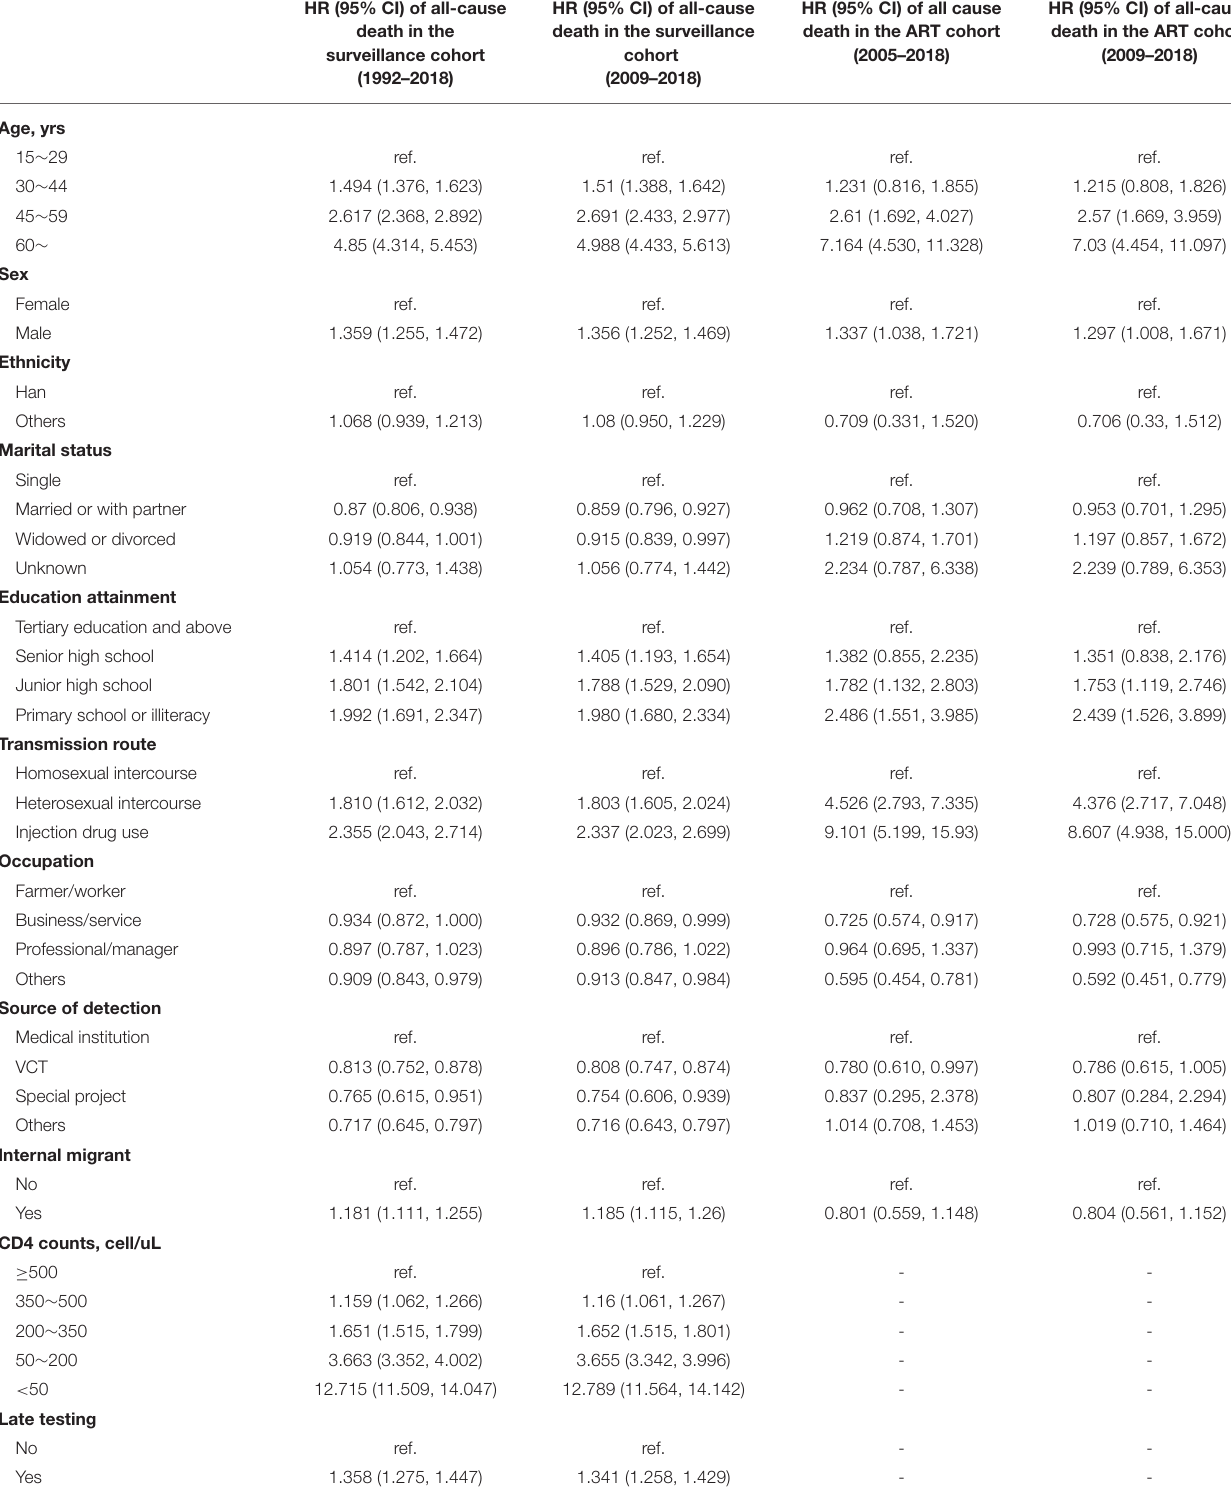
TABLE 3 | Risk factors summary of all-cause death from the extended Cox regression and joint modeling in the surveillance and ART